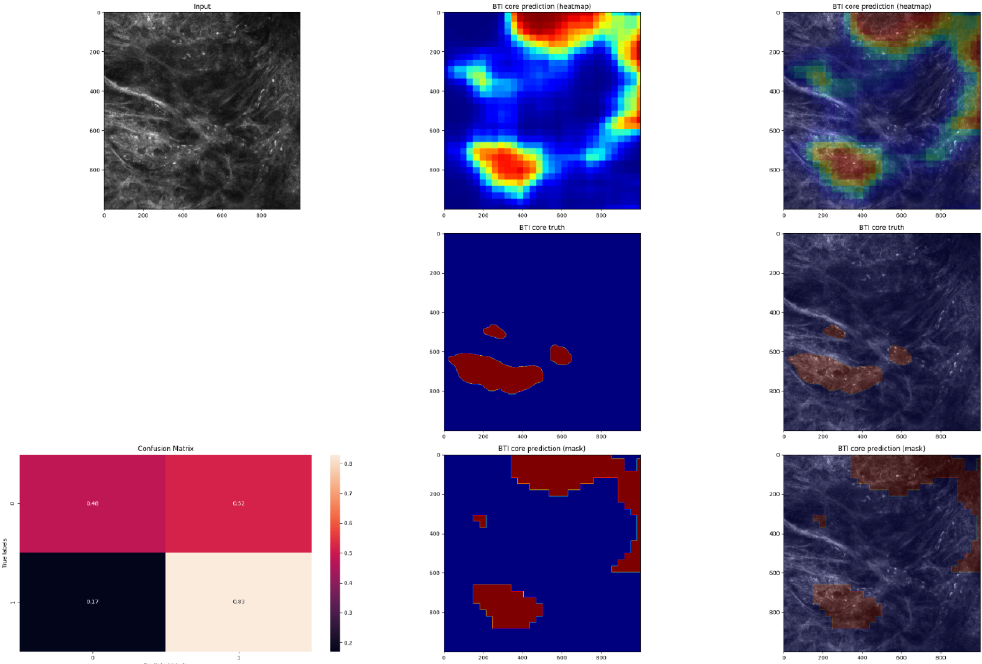
Figure 5. An example of an in vivo RCM image of a BCC that has been manually annotated for cancerous regions and has been predicted by an algorithm. An image of the predicted heatmap can also be seen in the image. Jet is a colormap that ranges from blue to red, where the former represents SCC and the latter, non-SCC. Using the methodology described in the Materials and Methods section, image shows the prediction mask generated from the heatmap. Additionally, a normalized confusion matrix is shown for each row. The class that is not SCC is represented by 0, and 1 represents the class that is SCC. As we can see in this example, this is an average-performing example. The lesions were predicted correctly, although not in their entirety.